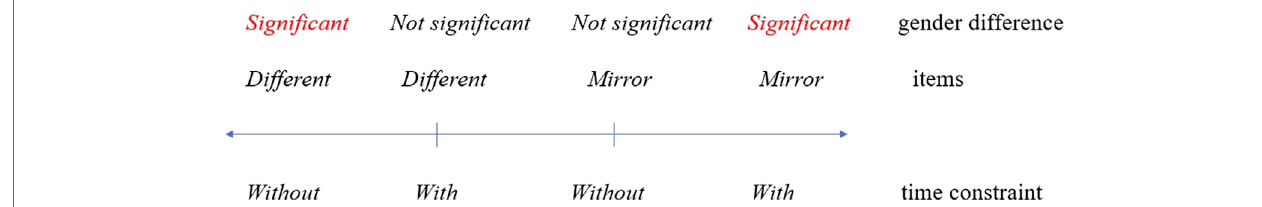
FIGURE 1 | Results of gender differences in Grade 4 by time constraint and item type.